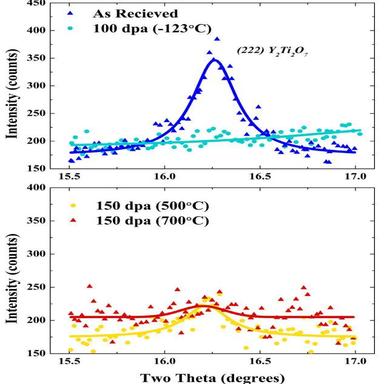
GIXRD patterns for an as- received and ion irradiated ODS alloy around the characteristic (222) reflection of the pyrochlore Y2Ti2O7 oxide phase at ~16.3 degrees. The complete loss of diffraction intensity with irradiation is clear in specimens irradiated at -123°C, while higher temperatures still show weak diffraction intensity. Figure data was extracted from ref .